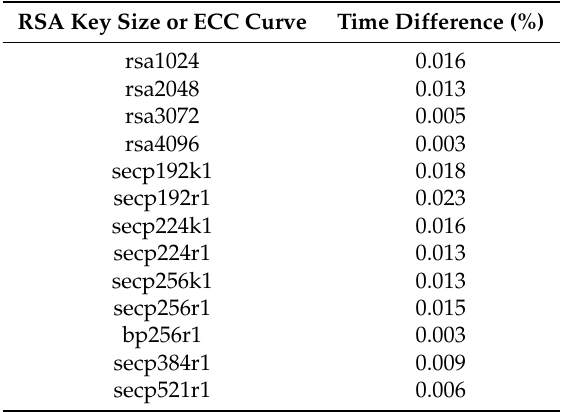
Table 3. Time difference (in percentage) between the energy measurement process and the file download process for the fog gateway to mist end-device